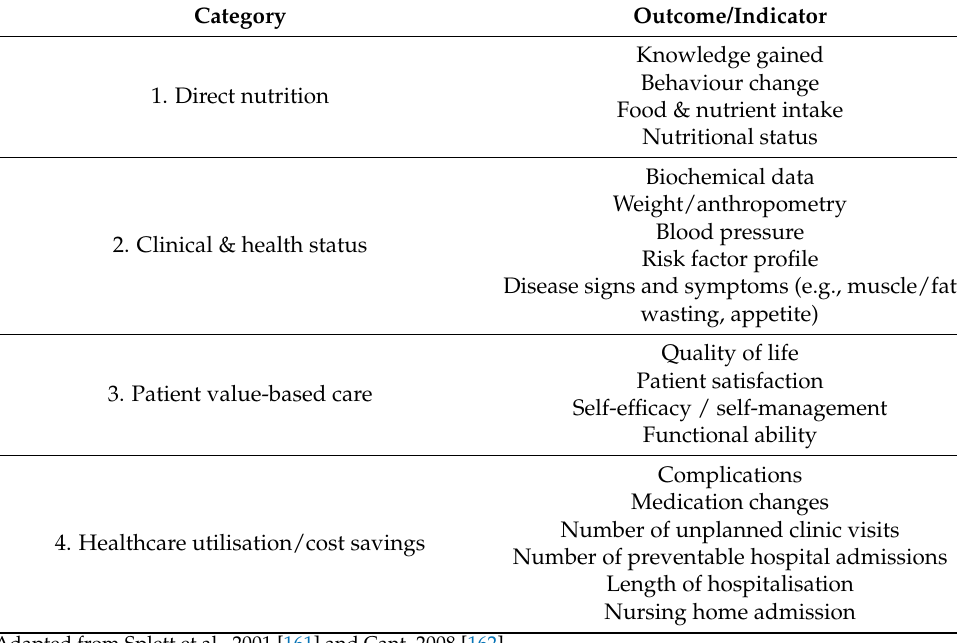
Table 5. Outcome/indictor categories to assess nutrition